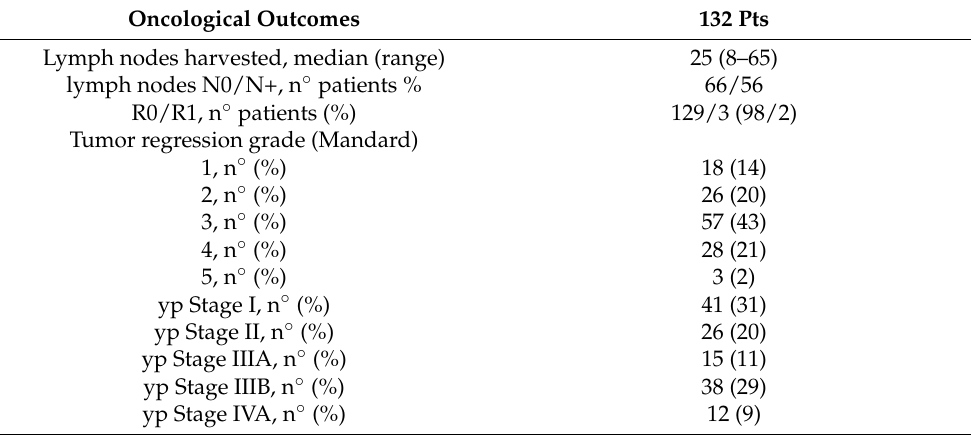
Table 2. Oncological